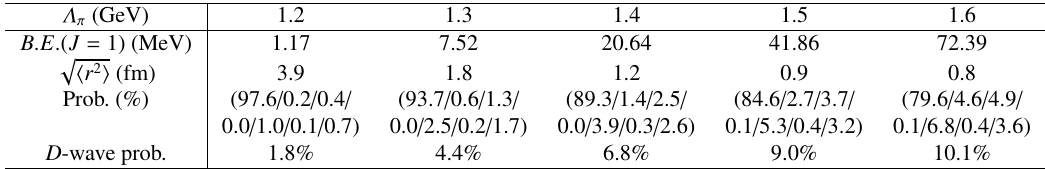
Table 4. Binding solutions for the J P = 1 + case with channel coupling in the OPEP model. The binding en- ergies (B.E.) are given with relative to the Λ c N threshold. The probabilities correspond to Λ c N ( 3 S 1 ), Σ c N ( 3 S 1 ),